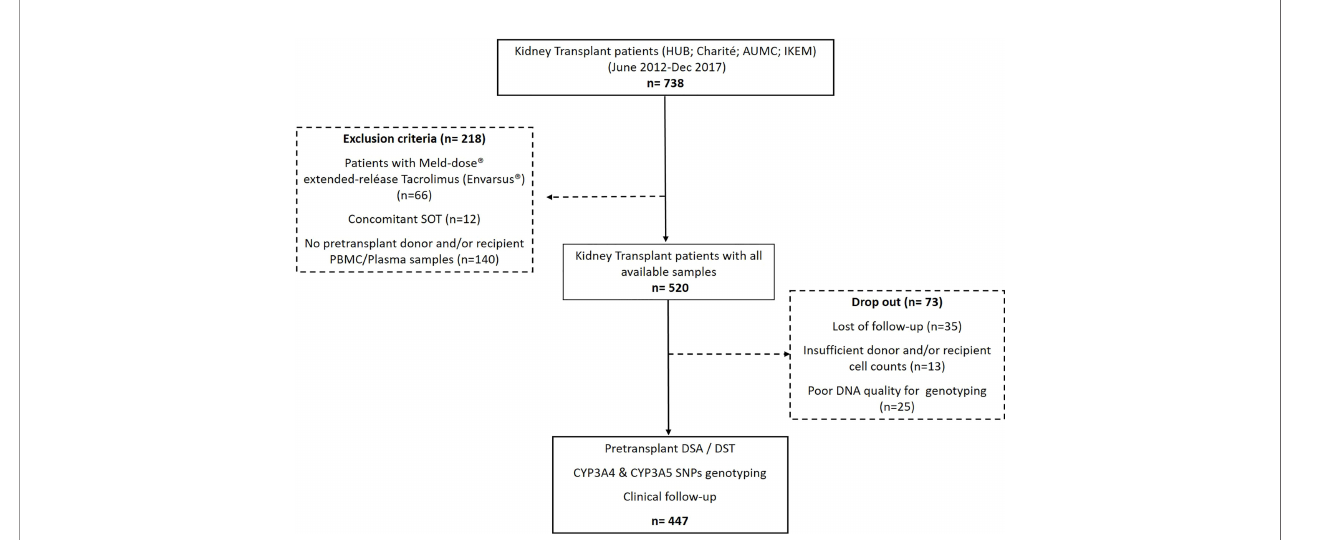
FIGURE 1 | Flowchart of the